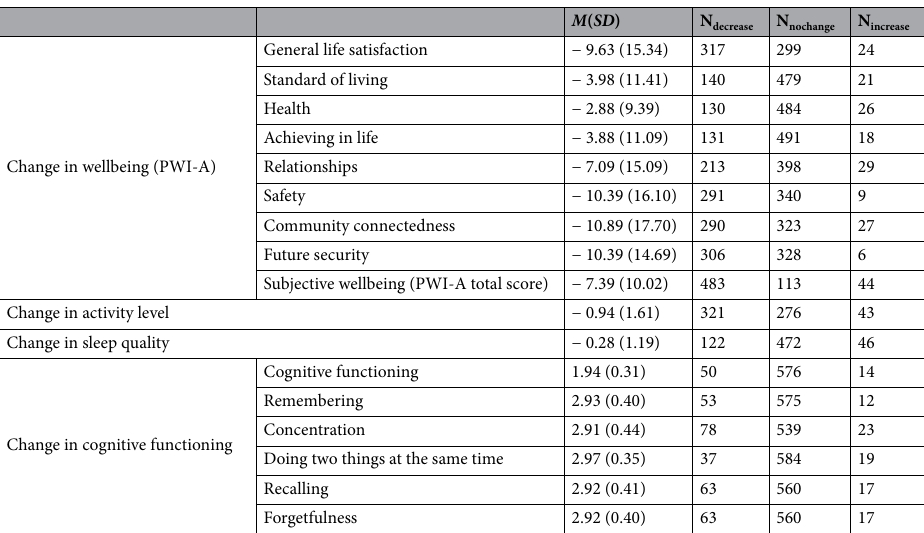
Table 2. Mean (SD) of the reported changes in wellbeing, activity level and sleep quality (all based on the calculated difference scores) and cognitive functioning (based on the subjective cognitive change questions) and the number of participants who reported a decrease (N decrease ), no change (N nochange ) or an increase (N increase ) in wellbeing, activity level, sleep quality and cognitive functioning based on the difference scores and the subjective cognitive change questions. For the subjective cognitive change questions assessing problems with remembering, concentration, doing two things at the same time, recalling and forgetfulness, the response options 1 = ”a lot more problems than before” and 2 = ”more problems than before” were grouped together and the response options 4 = ” less problems than before” and 5 = ”a lot less problems than before” were grouped together in the reported numbers of